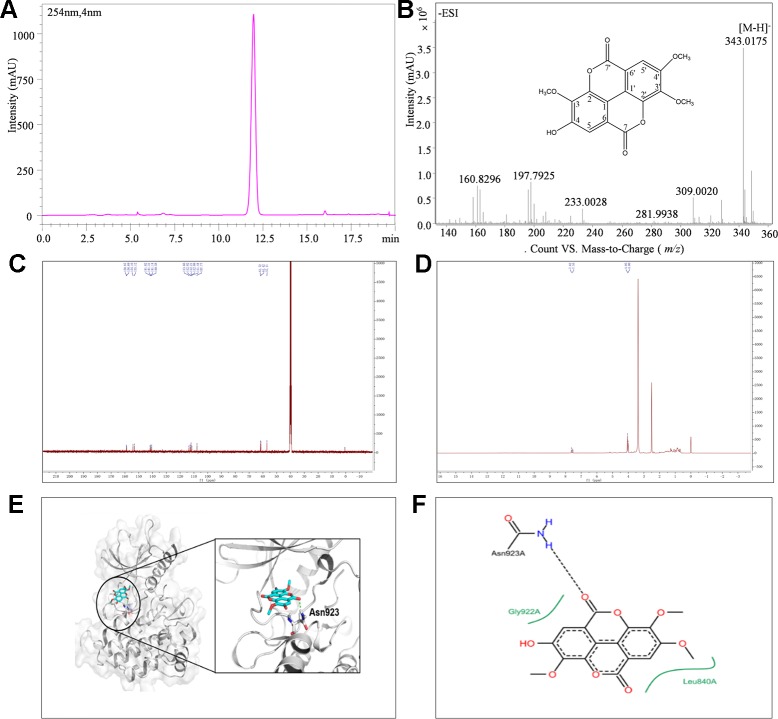
The structure and purity of TMEA. (A) Determination of TMEA by HPLC chromatography; (B) The molecular formula and determination of TMEA by MS chromatography; (C) Determination of TMEA by 13C-NMR chromatography; (D) Determination of TMEA by 1H-NMR chromatography; (E) The best scored docking pose of TMEA in the binding pocket of VEGFR2; (F) The interactions between TMEA and VEGFR2. TMEA, 3,3',4'-trimethylellagic acid; VEGFR2, vascular endothelial growth factor receptor 2.